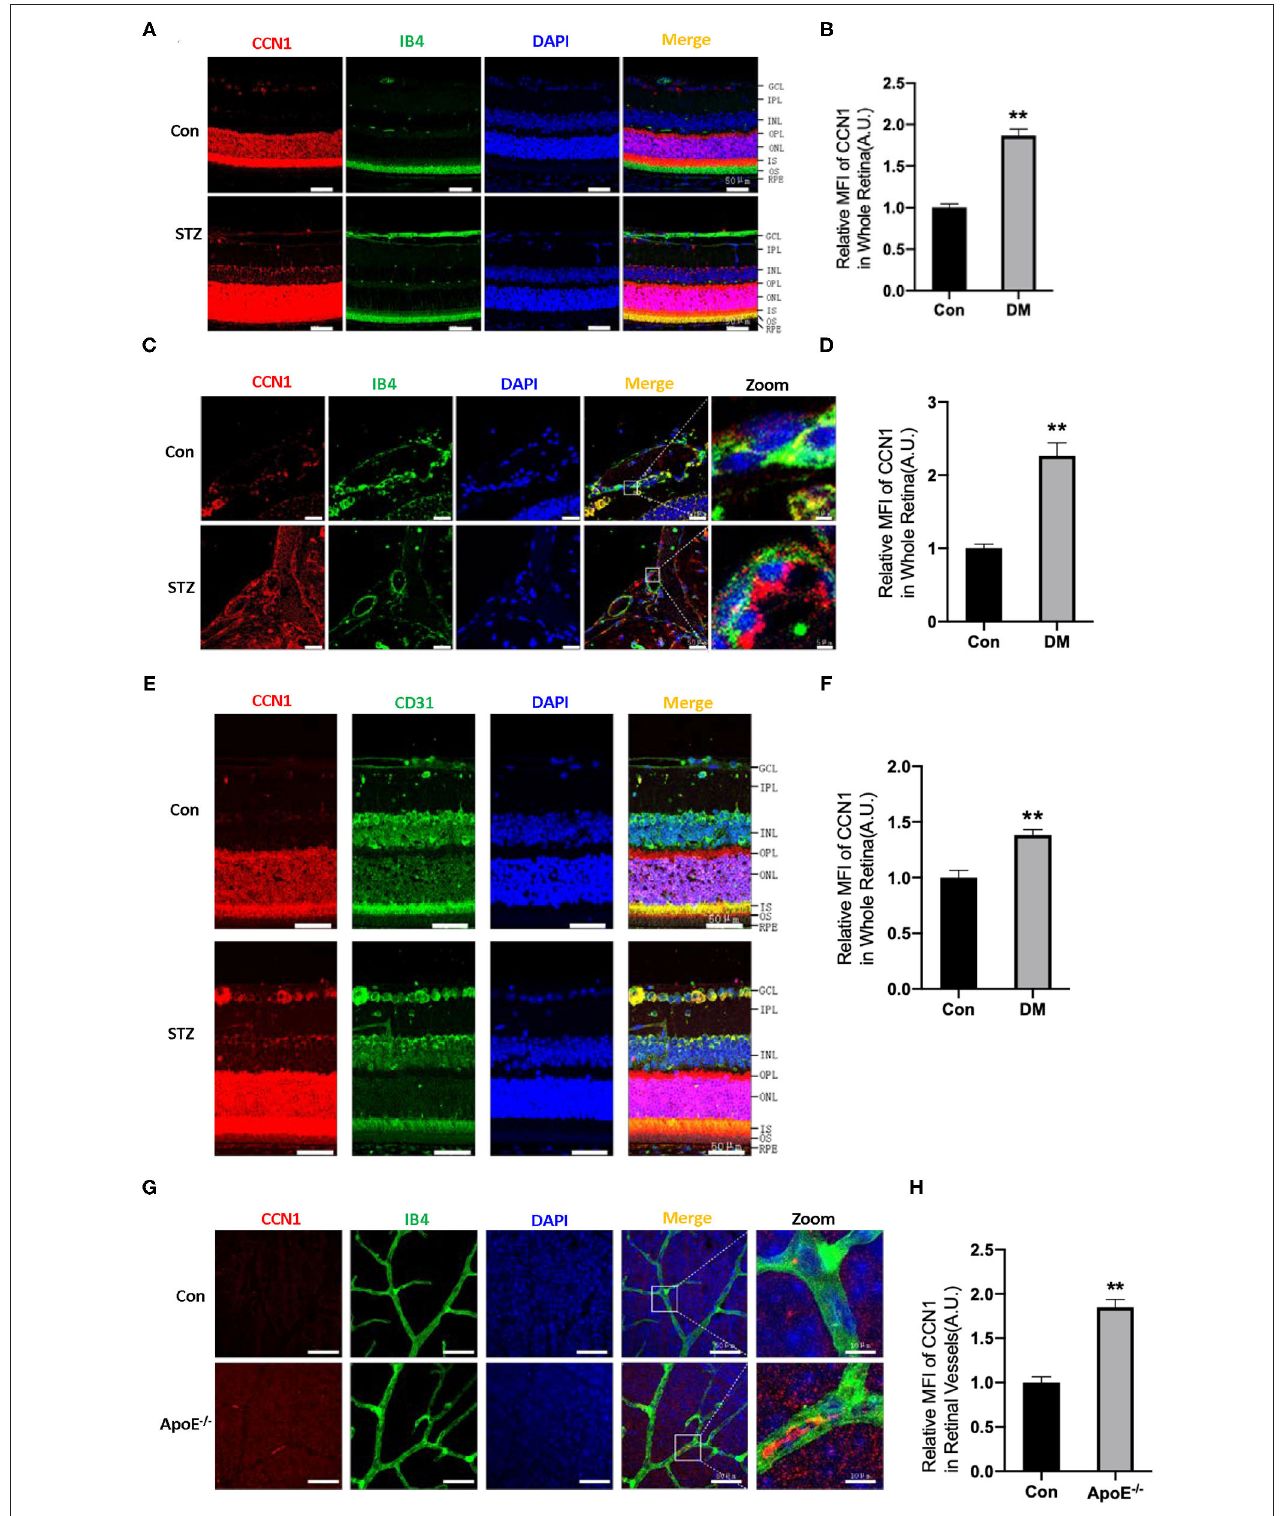
FIGURE 2 | CCN1 expression is increased in the retinal vessels of mice with diabetes mellitus (DM) and ApoE − / − mice. (A) Representative images of CCN1 expression patterns and (B) quantification of CCN1 mean fluorescence on frozen sections of the retina from control mice and streptozotocin (STZ)-induced hyperglycemic